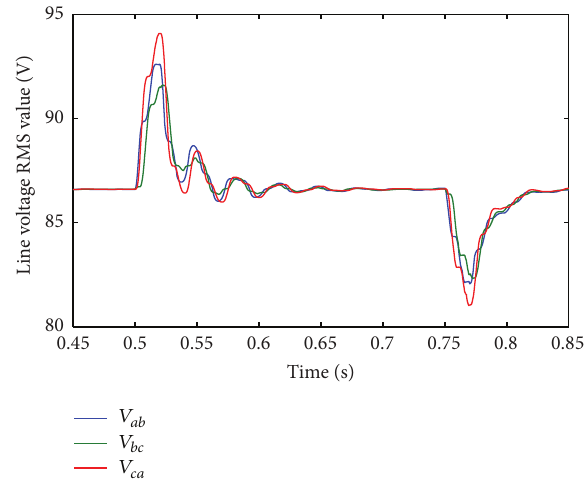
Figure 17: RMS of line-voltage response to DC sources disturbance. signal 𝑔 1 ∼ 𝑔 4 for four power switches 𝑆 1 – 𝑆 4 in one H- bridge of CHB converter can be generated as shown in Figure 19. The H-bridge’s output voltage is V 𝐻 . The high voltage level in 𝑔 𝑖 (𝑖 = 1, 2, 3, 4) means that the corresponding switch 𝑆 𝑖 is turned on and low voltage level means that the corresponding switch 𝑆 𝑖 is turned off.